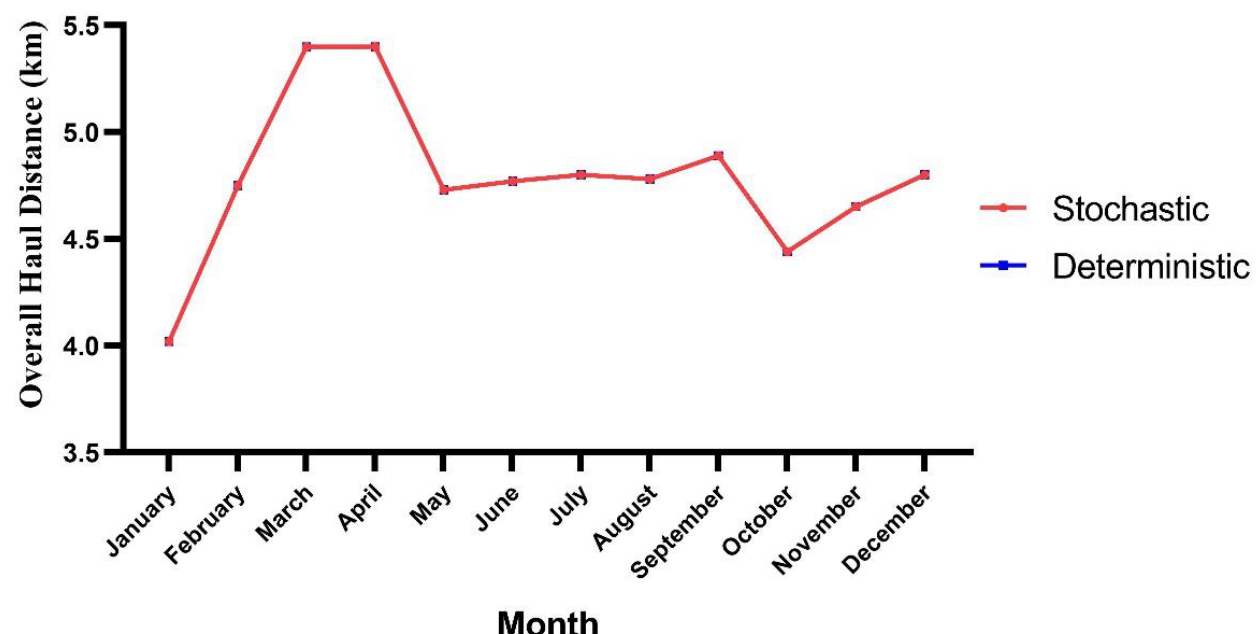
Figure 13. Overall haul distance in the stochastic and deterministic models.